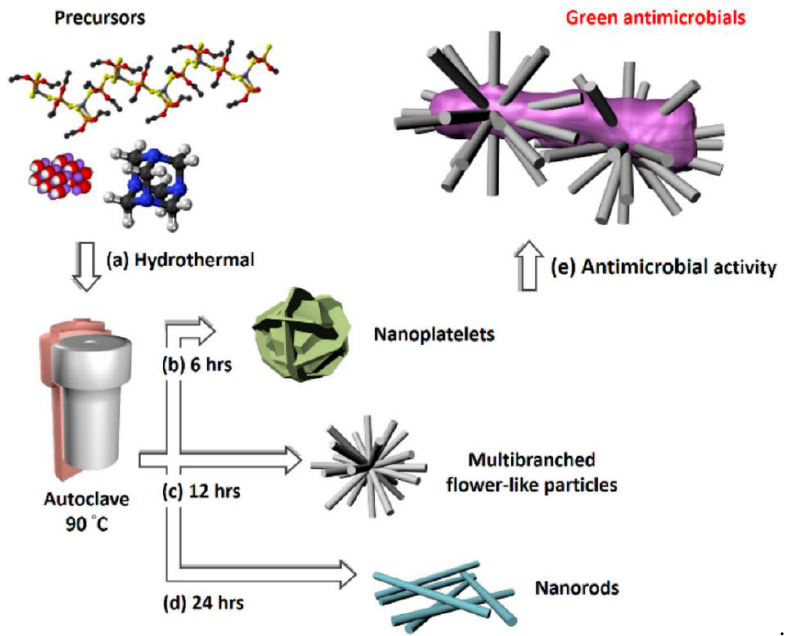
Figure 8. ( a ) Precursors (zinc acetate, hexamethylenetetramine (HMT), and sodium hydroxide) used in the synthesis of different nZnO morphologies; auto-clave treatment at 90 ◦ C was maintained for ( b ) 6 h to get nanoplatelets, ( c ) 12 h to achieve multibranched flower-like particles, and ( d ) 24 h to obtain nanorods. ( e ) Diagram of the antimicrobial activity test for the ZnO multibranched flower-like particles. Figure adapted with permission from Reference [129]. Copyright 2020